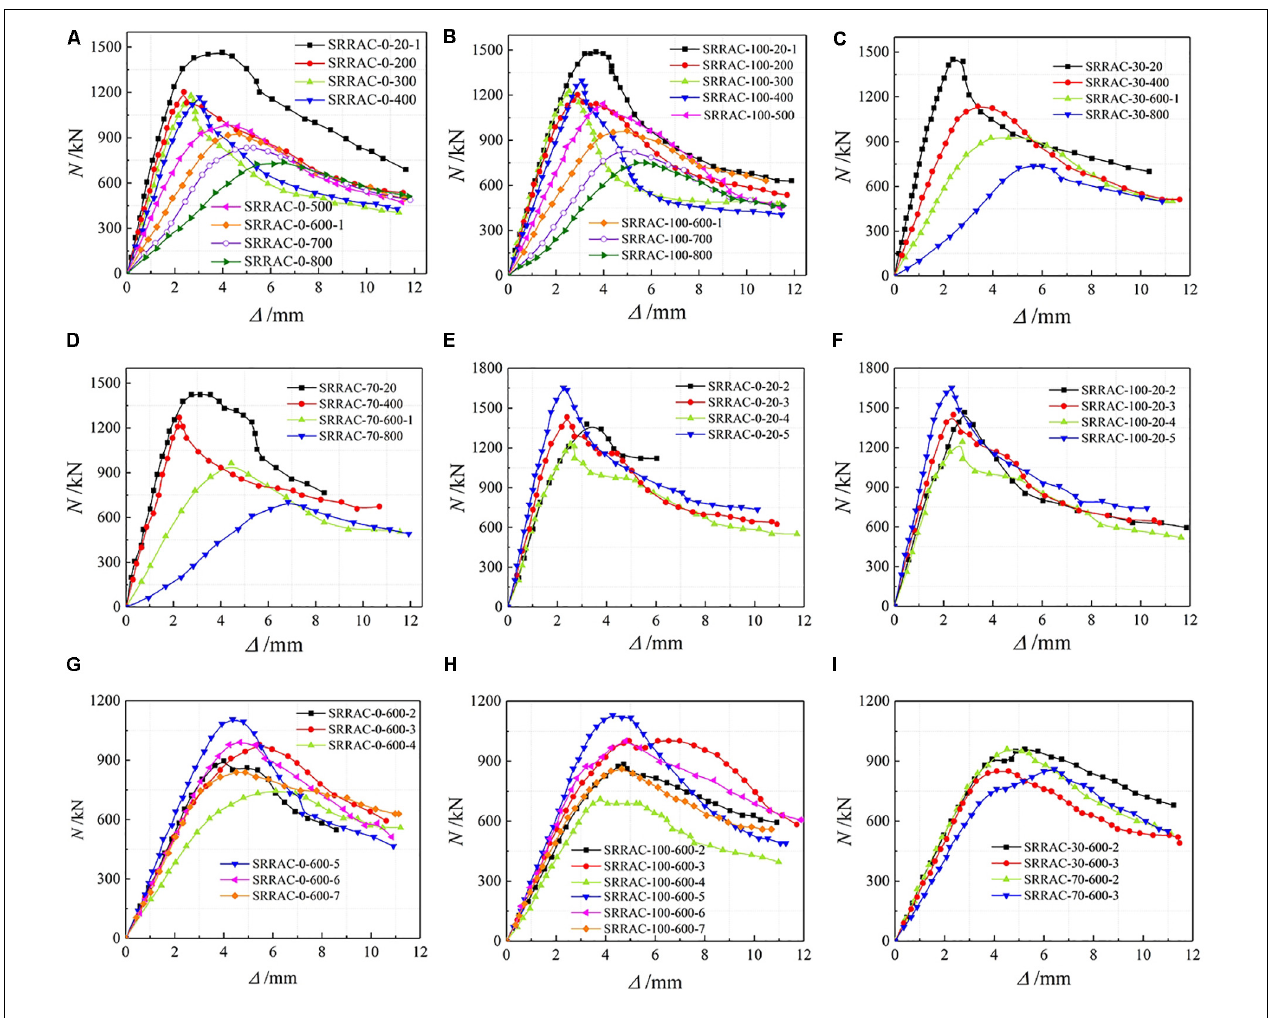
FIGURE 4 | Load-deformation curves of specimens . (A) r = 0%, (B) r = 100%, (C) r = 30%, (D) r = 70%, (E) r = 0%, T max = 20 ◦ C, (F) r = 30%, T max = 20 ◦ C, (G) r = 0%,